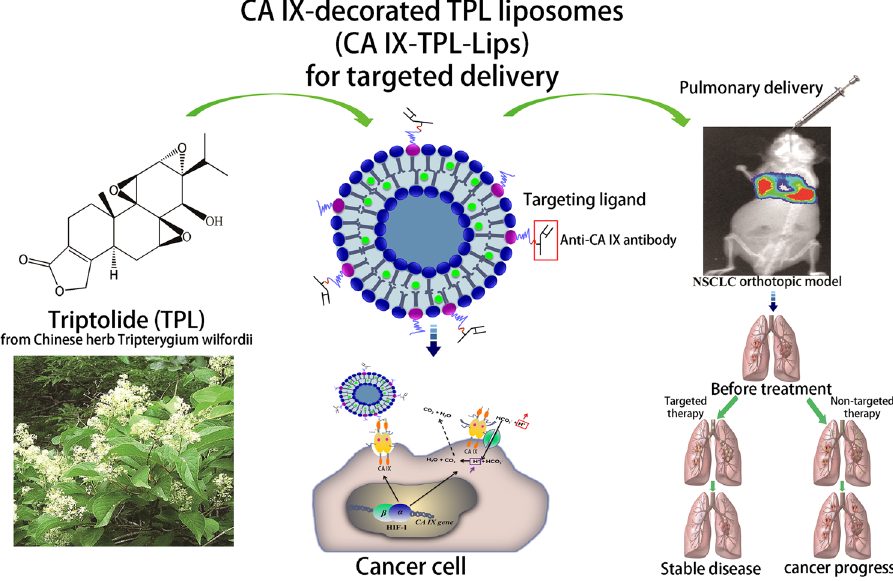
Figure 1. Schematic representation of CA IX-decorated TPL liposomes (CA IX-TPL-Lips) for lung cancer- targeted therapy by pulmonary